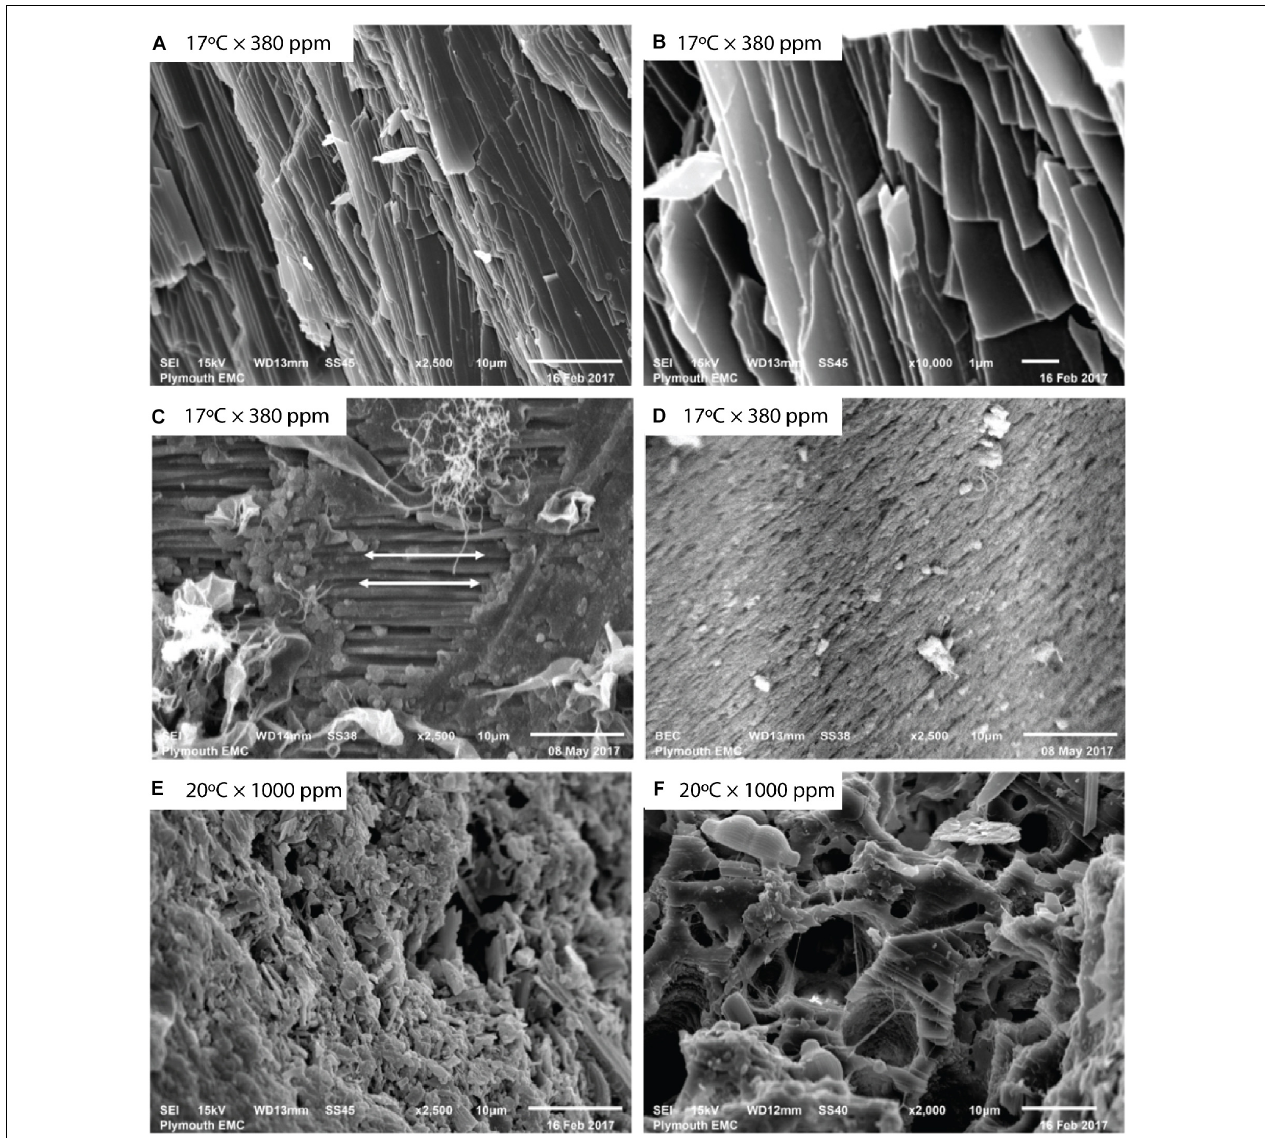
FIGURE 1 | Mytilus sp. valves imaged using backscattered electron (BSE) imaging. Unprepared baseline Mytilus (A,B) show naturally occurring aligned crystalline structures at (A) 2500 × , and (B) 10,000 × magnification before specimen preparation. Prepared baseline specimens (C,D) at 2500 × magnification reveal differences in prismatic and nacre layers showing (C) aligned crystalline structure as indicated by arrows, and (D) more porous structure with lack of an observable regular crystalline alignment. Mytilus exposed to elevated temperature and pCO 2 (E,F) show (E) disrupted, irregular structure, and (F) a fragmented, porous